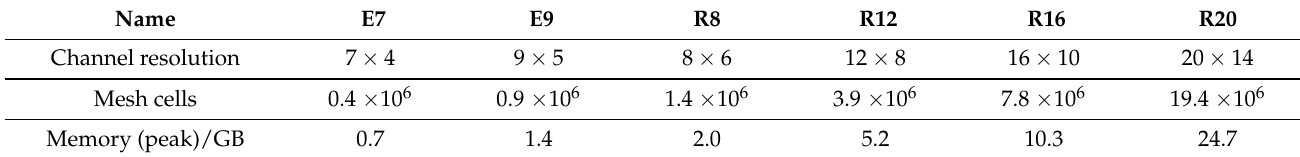
Table 4. Mesh configurations for a geometric area of 10cm 2 with a channel width of 0.9mm.